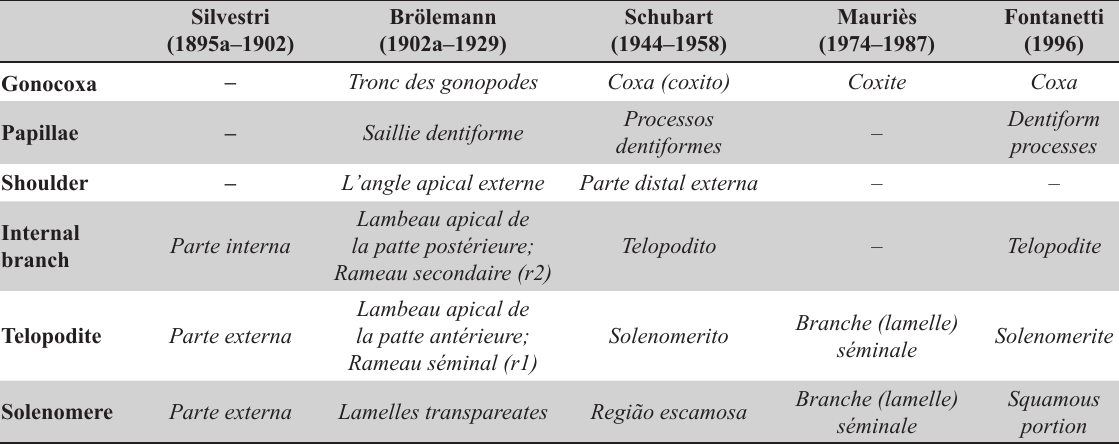
Table 1. Different terminologies proposed for gonopod in Pseudonannolene Silvestri,1895.